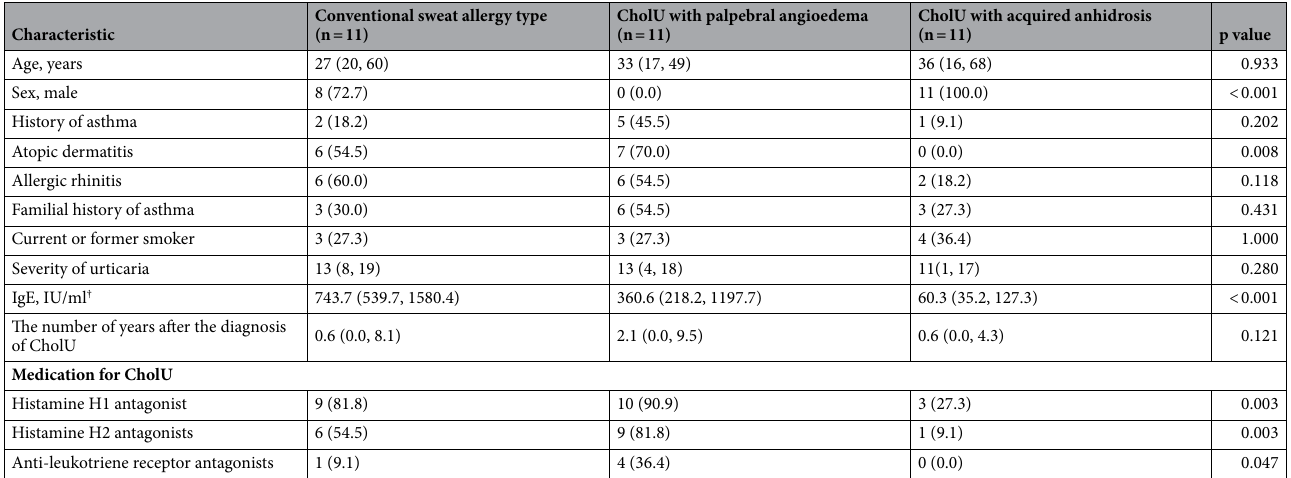
Table 1. Patient characteristics for each subtype of CholIU. Values are shown as median (range) or n (%) unless otherwise indicated. CholU cholinergic urticaria. † Shown as median (25th, 75th